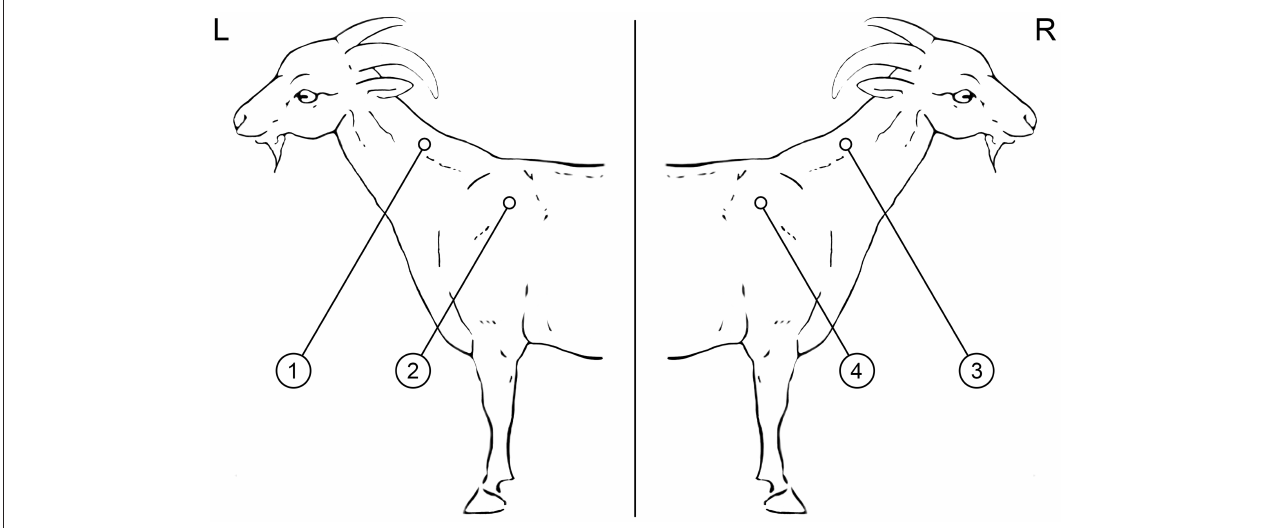
FIGURE 1 | Location of bovine and avian PPD injection sites. (L) Left side: (1) Bovine PPD cervical, (2) Bovine PPD scapular; (R) Right side: (3) Avian PPD cervical, (4) Avian PPD